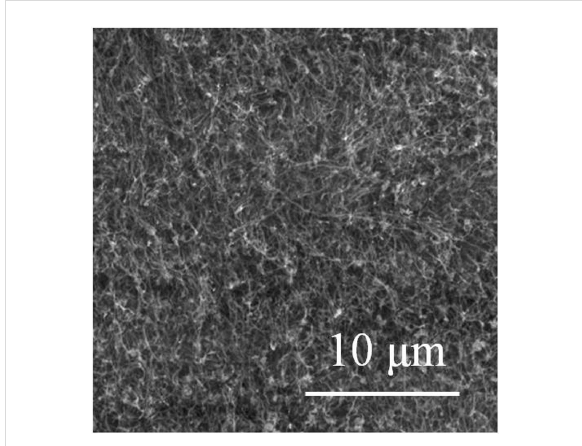
Figure 4: Core-valence-valence (CVV) Auger spectra of MWCNTs (red curve) and HOPG (black curve). An electron gun with a primary beam energy of 1500 eV was used as the exciting source. In the case of the MWCNT sample, the Auger peak is shifted towards lower kinetic energy with respect to HOPG. The Fermi level is at 284.4